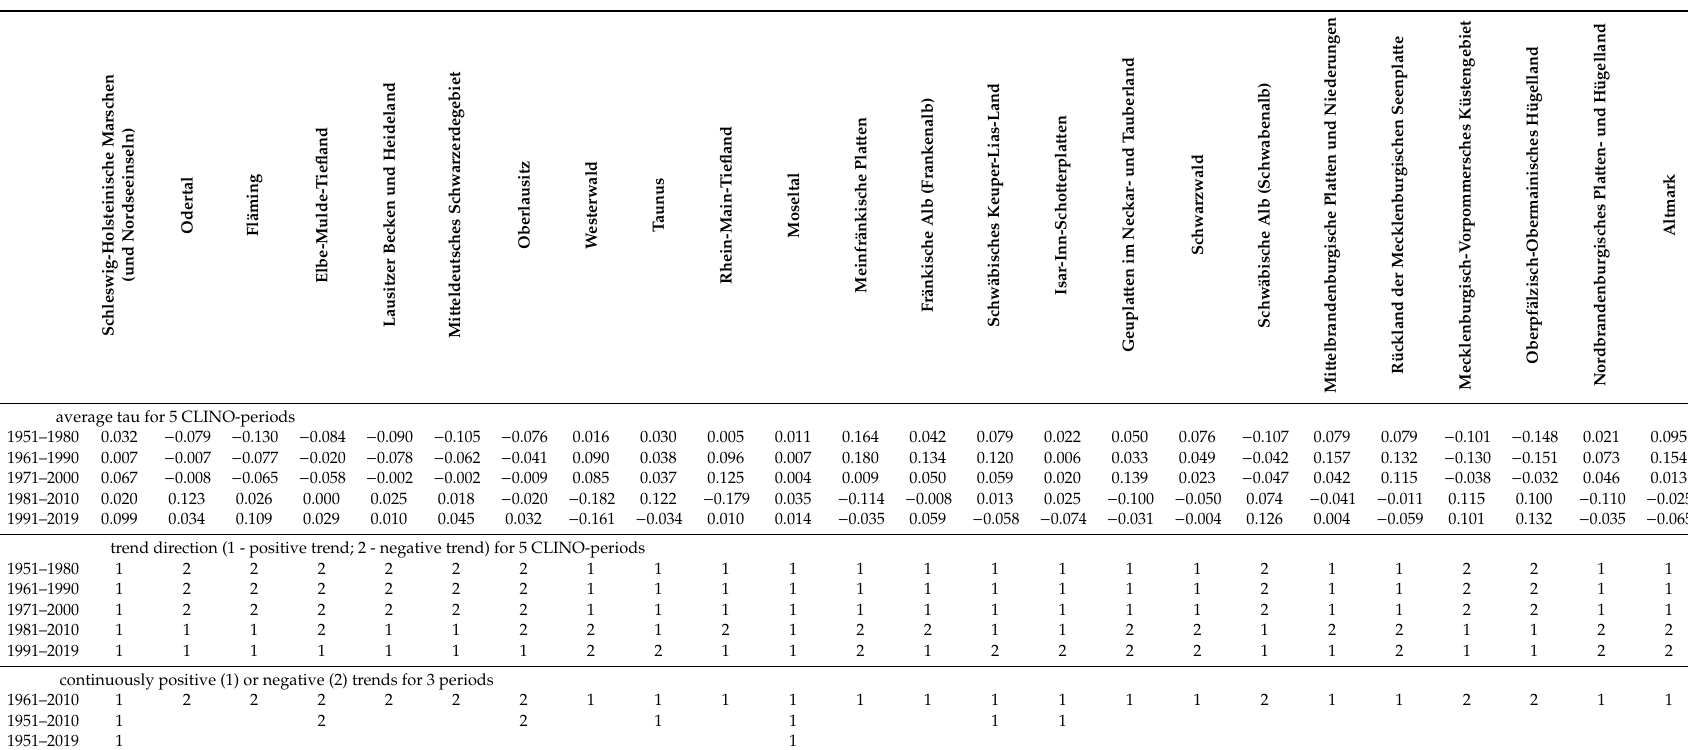
Table A2. Trend directions in natural regions (cf. Figure A2), an example of annual days with ≥ 20 mm